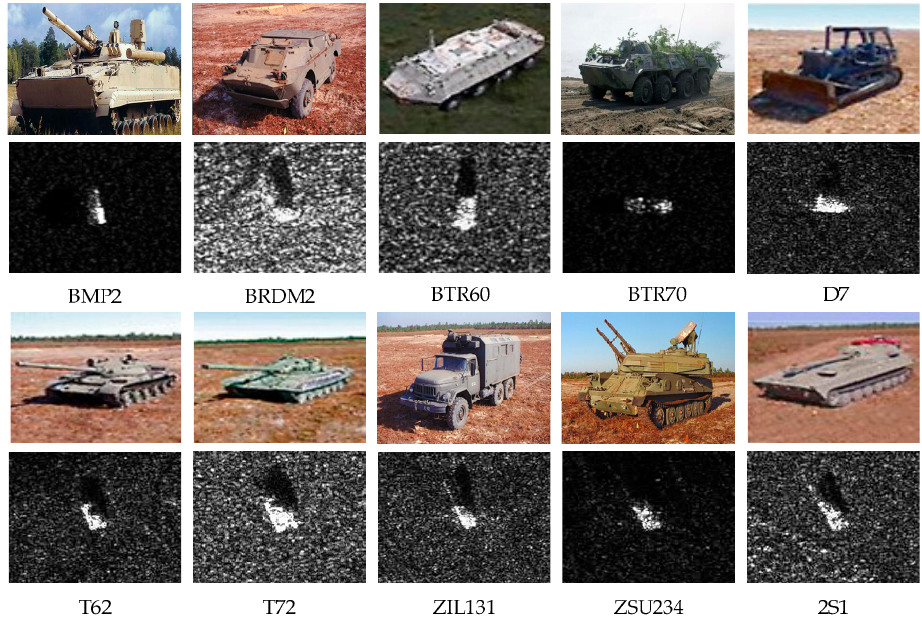
Figure 8. Samples of each type of vehicle in MSTAR with corresponding optical images. Table 3. The quantity of training and testing images.